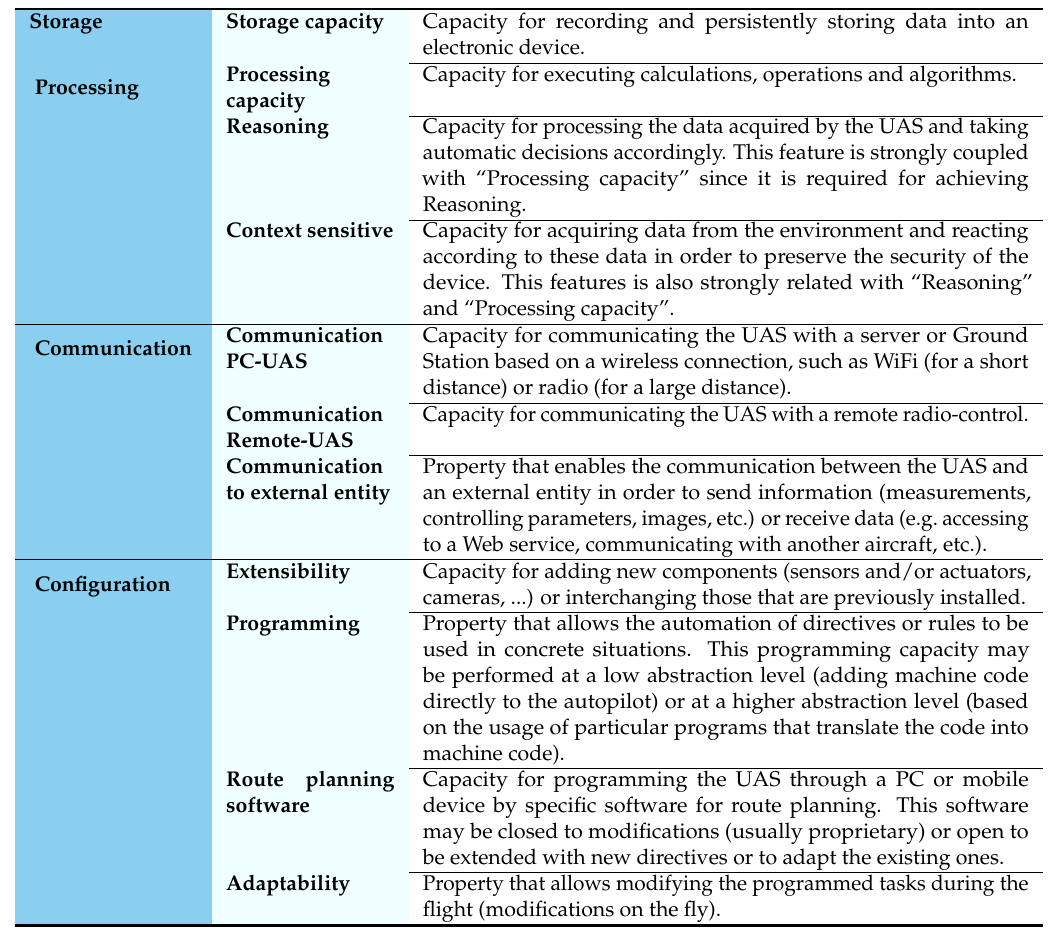
Table 2. Feature